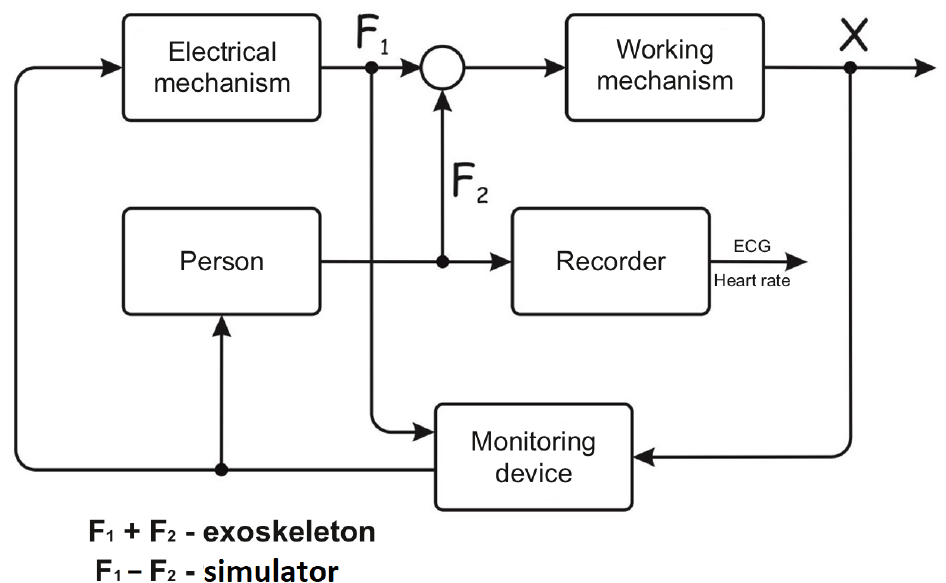
Figure 13. Structural diagram of the system of force interaction between a person and a “machine” with an ECG link.